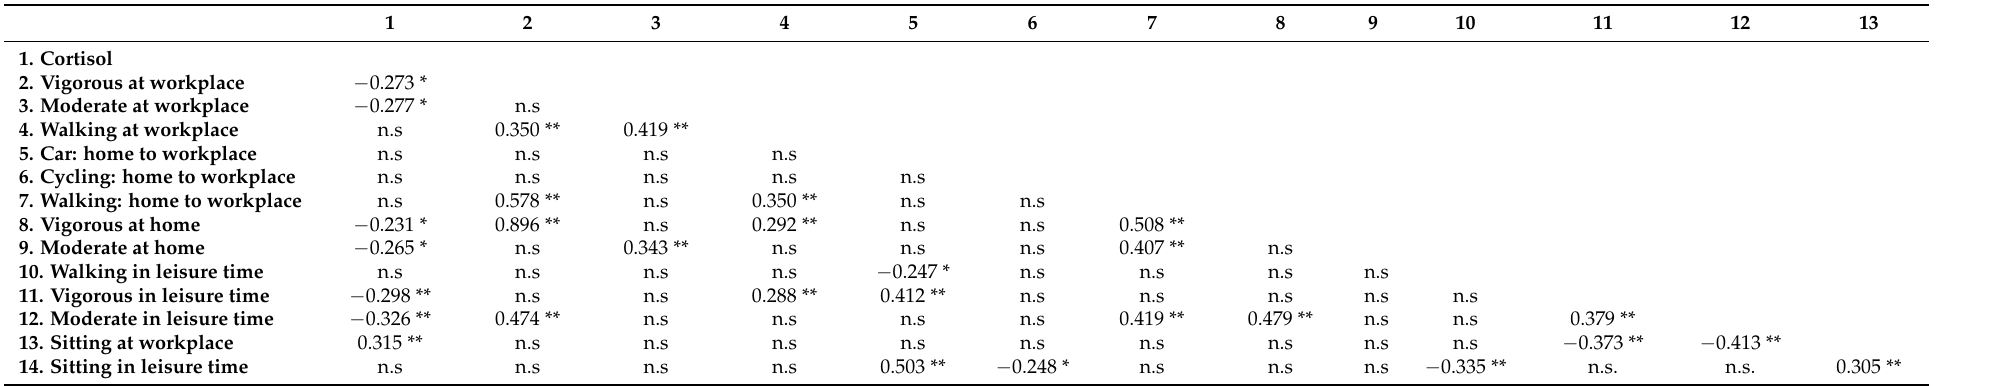
Table 2. Pearson-product moment correlation matrix: cortisol and physical activity.